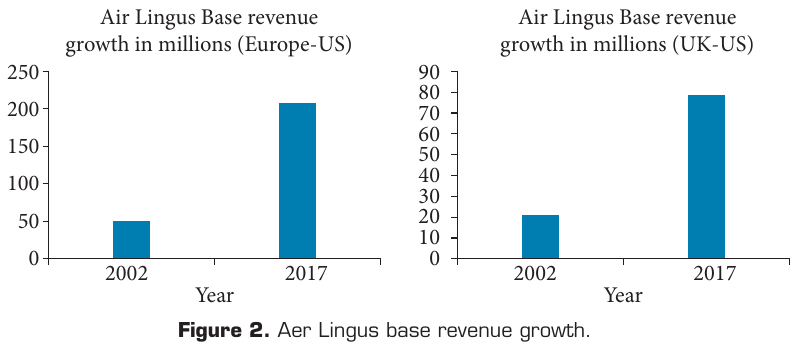
Figure 2. Aer Lingus base revenue growth. Source: MIDT